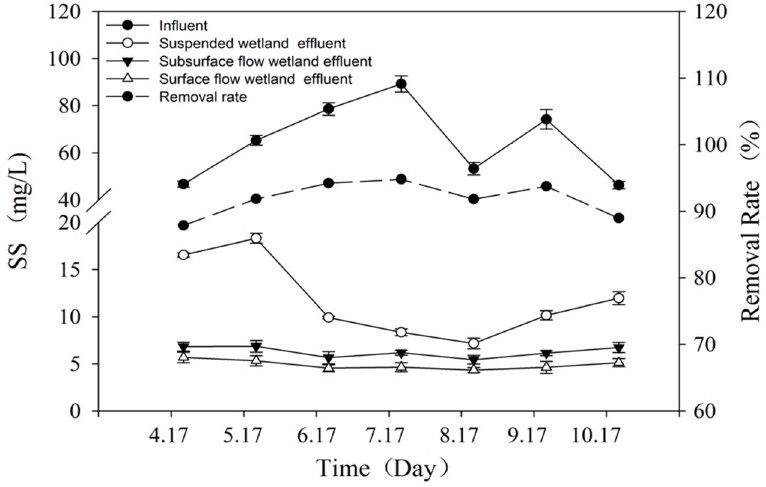
Figure 3. Concentration of SS in the inflow and outflow and the removal rate.